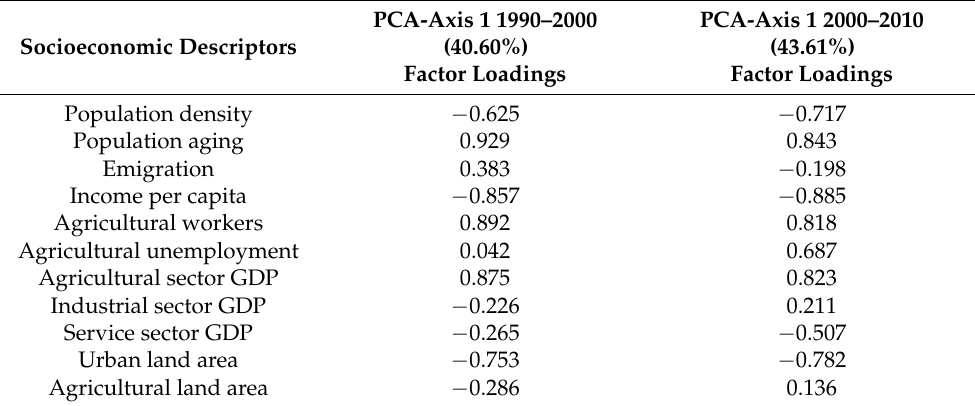
Table 3. Factor loadings of the socioeconomic descriptors on PCAs-Axes 1 of the two analysed periods (variance absorptions are shown in brackets). Loadings of the variables identified as key indicators of the socioeconomic structure of local population over time are indicated in italics (see Figure